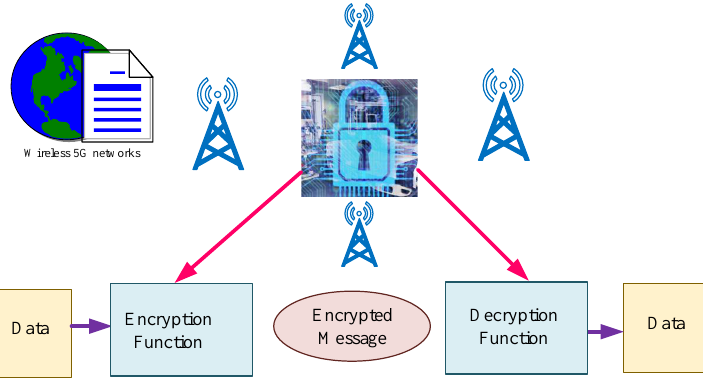
Figure 26. Cryptography science as a solution for providing security in biomedical devices.